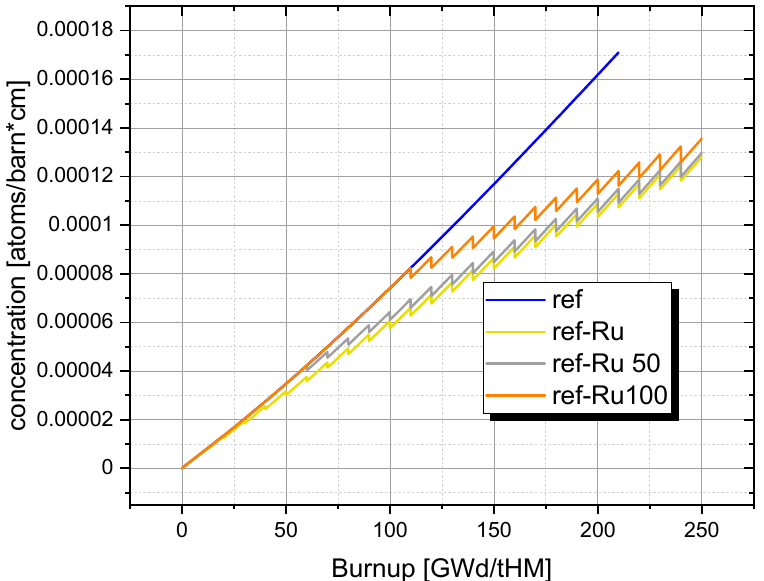
Figure 6. Development of the Ruthenium concentration as produced in HELIOS during the reactor operation investigating the effect of the time of the start of salt clean-up withdrawing each time 5% of the elementary concentration.